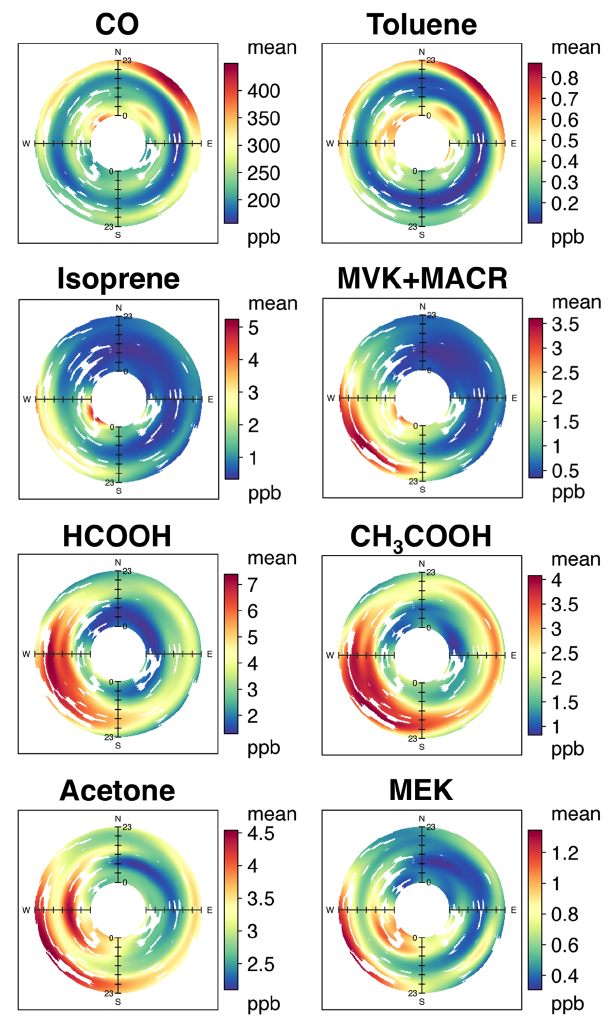
Figure 11. Diurnal cycle of HCOOH and related chemicals during SLAQRS as a function of wind direction, with time of day (LST) plotted radially. Plots generated using open air (Carslaw and Rop- kins,